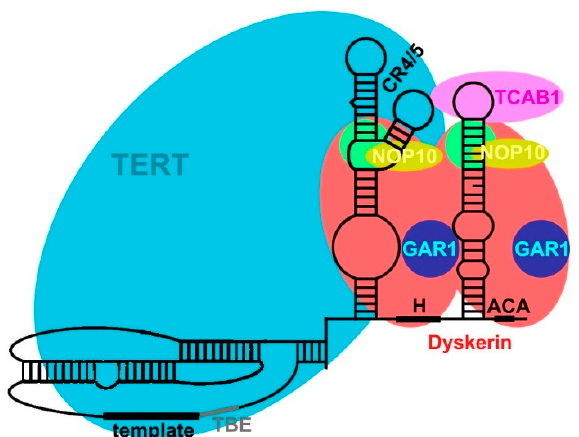
Figure 3. Human telomerase holoenzyme. TERC (structure in black) comprises the pseudoknot/tem- plate core domain (including template and template boundary element, TBE) and the CR4/5 domain (three-way junction), which are associated with TERT. In the scaRNA domain, two dyskerin mole- cules are bound to TERC through the H and ACA boxes. NHP2 (in green) and TCAB1 are also bound to TERC, while NOP10 and GAR1 are bound to dyskerin.